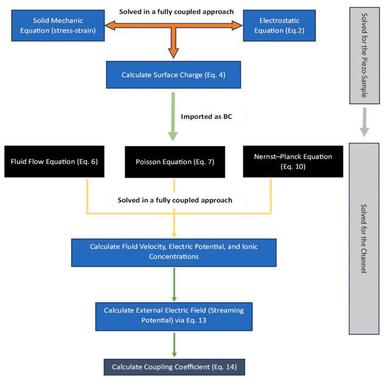
The flowchart of the algorithm in the streaming potential modeling.